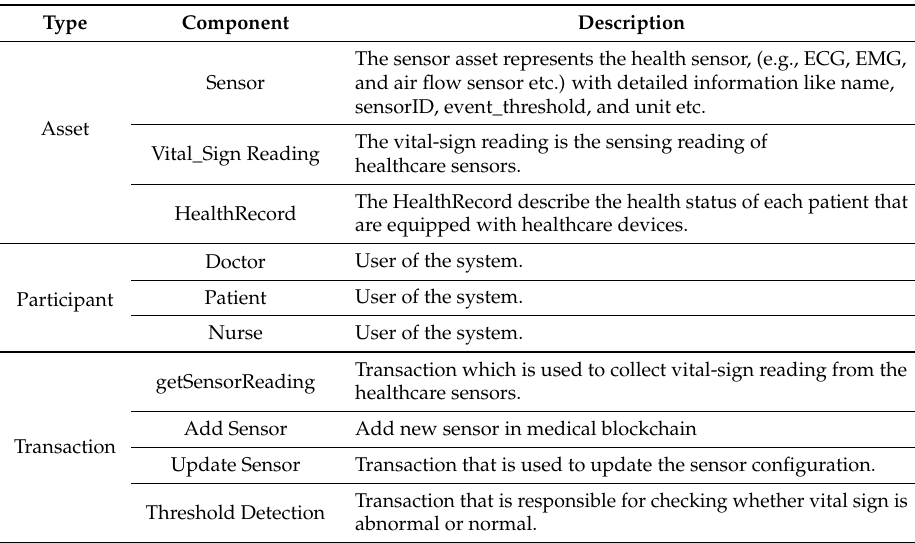
Table 1. Smart Contract Modeling for Proposed Vital-Sign